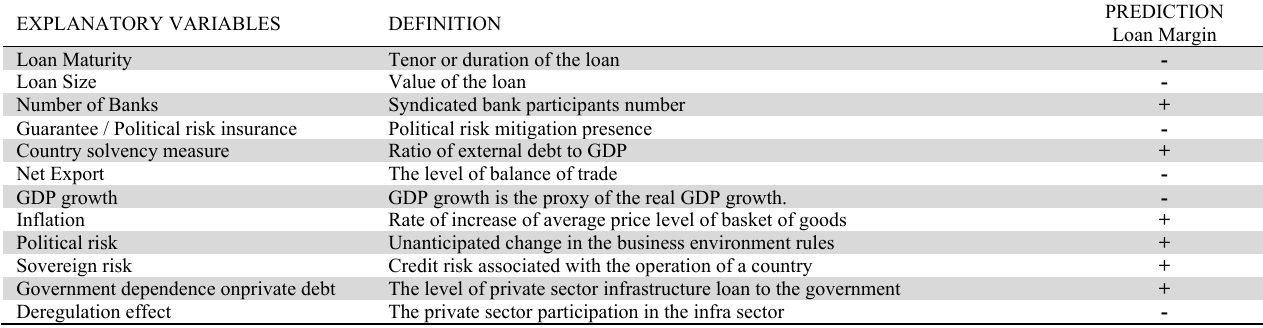
Definition of variables and its prediction EXPLANATORY